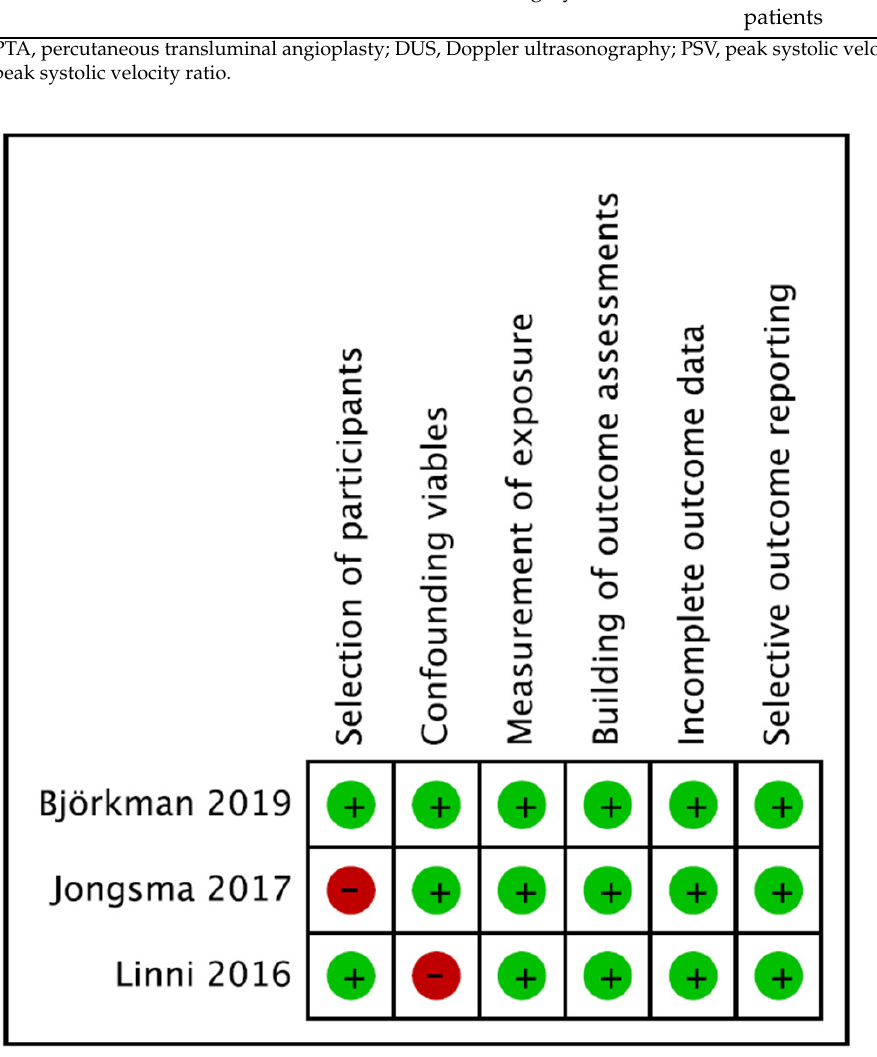
Figure 2. Risk of Bias Assessment Tool for Nonrandomized Studies (RoBANS) [22–24]. + in green circle meants “High”. − in red circle means